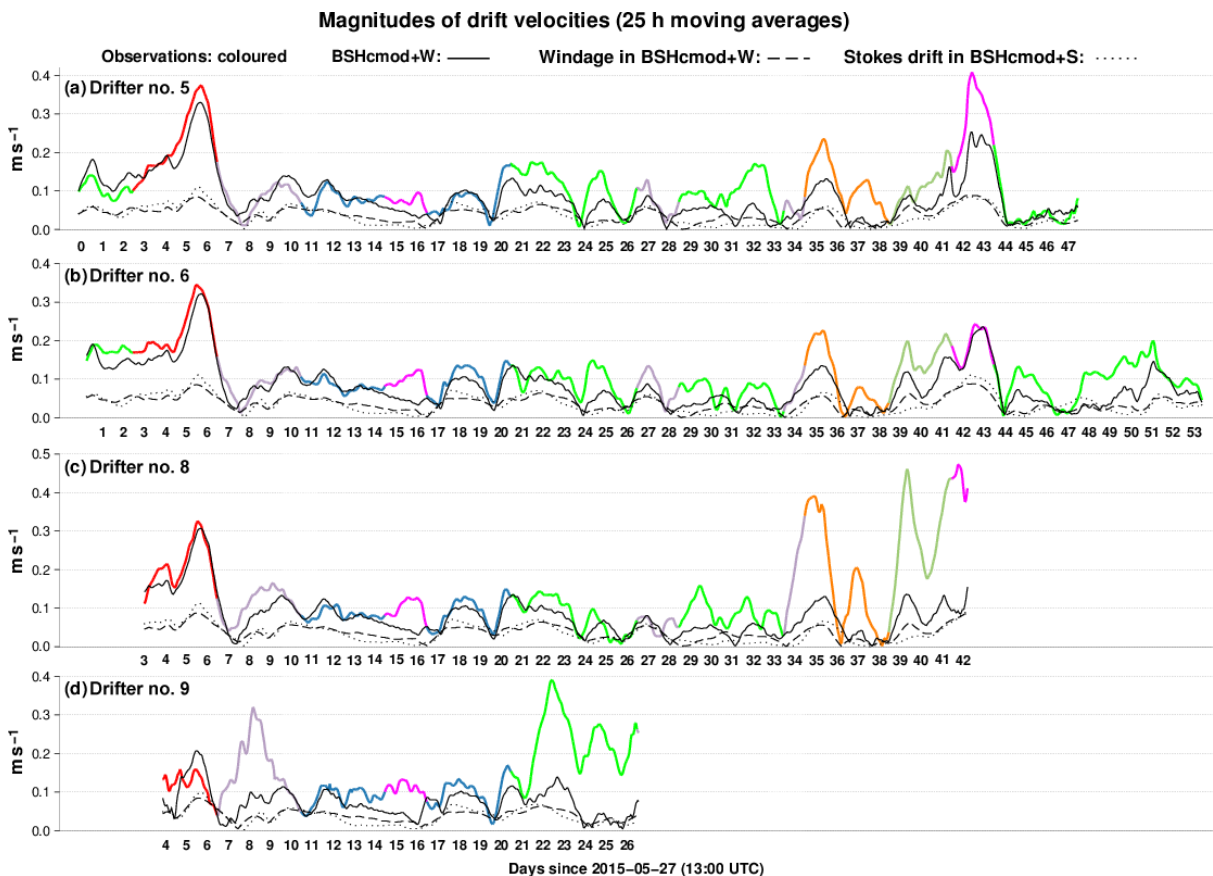
Figure 6. Magnitudes of 25h moving averages of drift velocity vectors, considering drifter nos. 5, 6, 8 and 9. Magnitudes of observed velocity vectors (coloured) are compared with simulations based on BSHcmod + W. In addition, magnitudes of windage (in BSHcmod + W) and Stokes drift (in BSHcmod + S) are shown. All model values were interpolated to observed (not simulated) drifter locations prior to